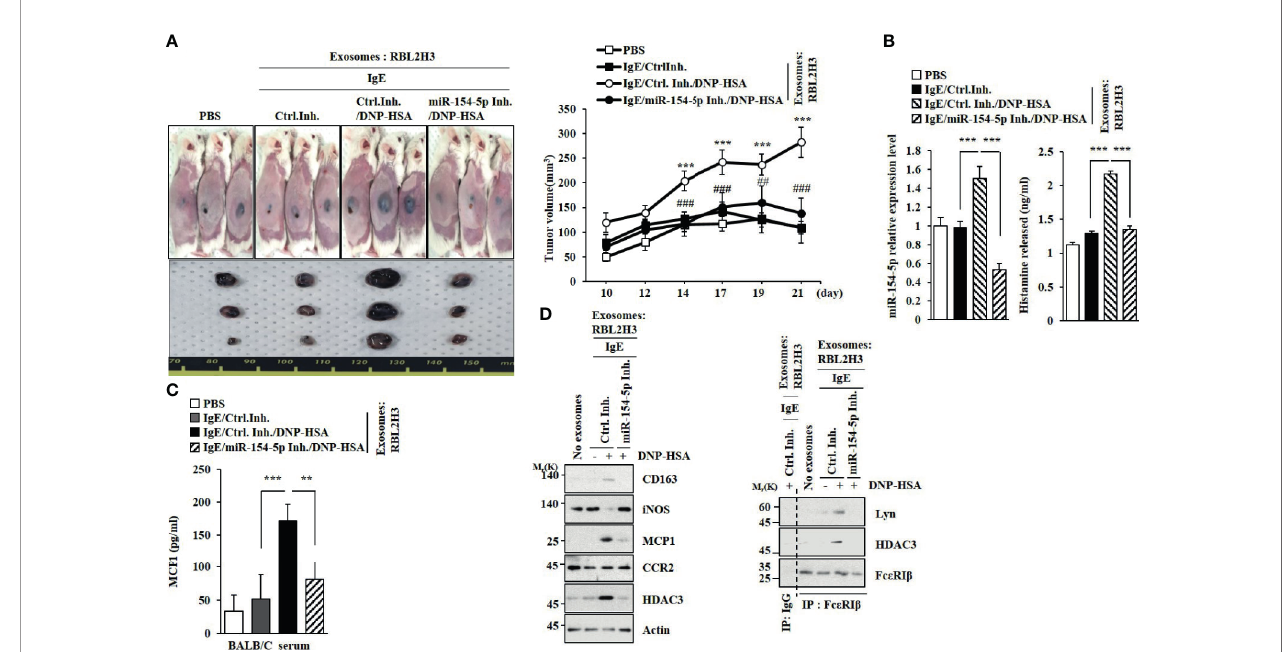
FIGURE 9 | Exosomes enhance the tumorigenic potential of cancer cells in an miR-154-5p-dependent manner. (A) Exosomes were isolated from culture medium of RBL2H3 cells. Exosomes (50 m g) were mixed with B16F1 cells (2X10 5 ). BALB/C mice were given a subcutaneous injection. *** p <0.001 compared with IgE/Ctrl. Inh. ## p <0.01, ### p <0.001 compared with IgE/Ctrl. Inh./DNP-HSA. (B) QRT-PCR analysis was performed. The level of histamine released was also determined. ***p<0.001. Average values of three independent experiments are shown. (C) Serum level of MCP1 was determined. ** p <0.01; *** p <0.001. Average values of three independent experiments are shown. (D) Immunoblot and immunoprecipitation were performed. Representative blots of three independent experiments are